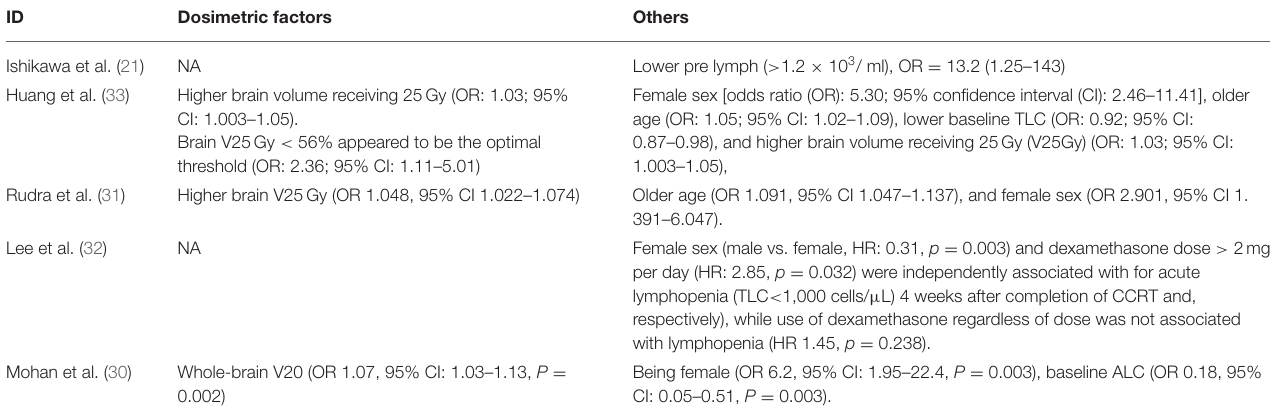
TABLE 3 | Risk Factors for developing Lymphopenia on Multivariate logistic regression analysis. ID Dosimetric factors